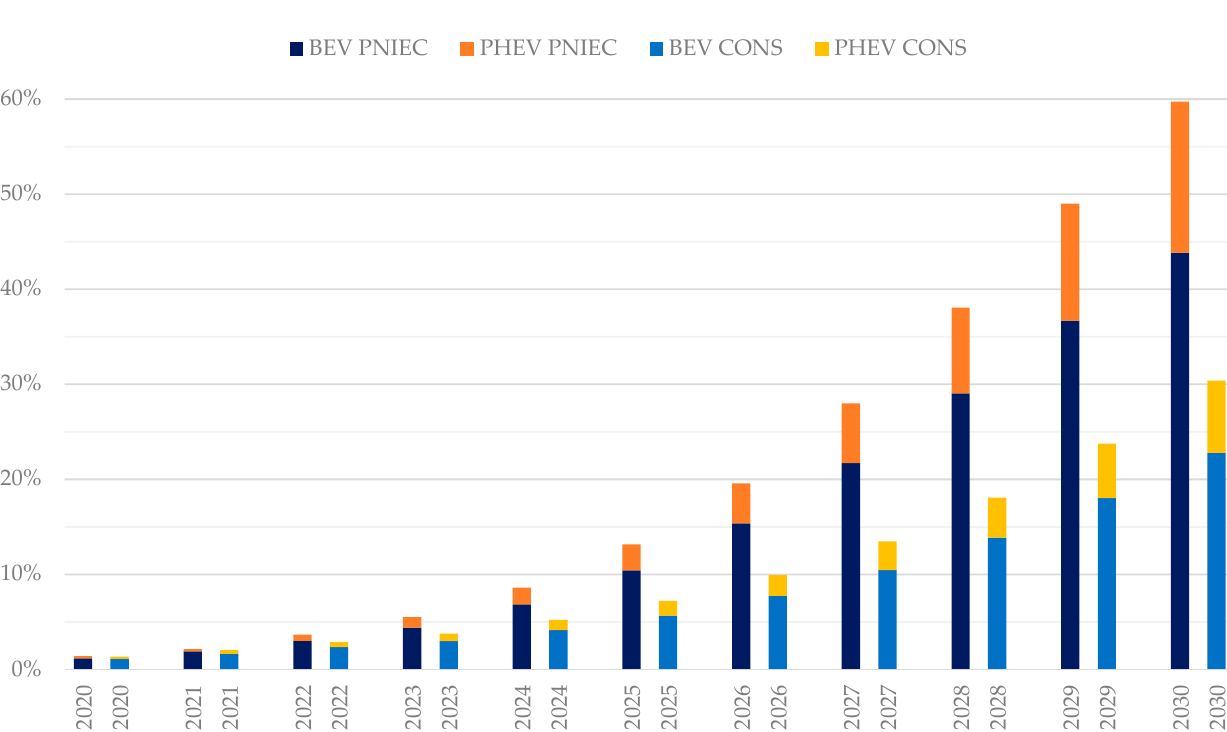
Figure 16. EVs penetration index forecast for Rome–Fiumicino airport for taxis and chauffeurs.